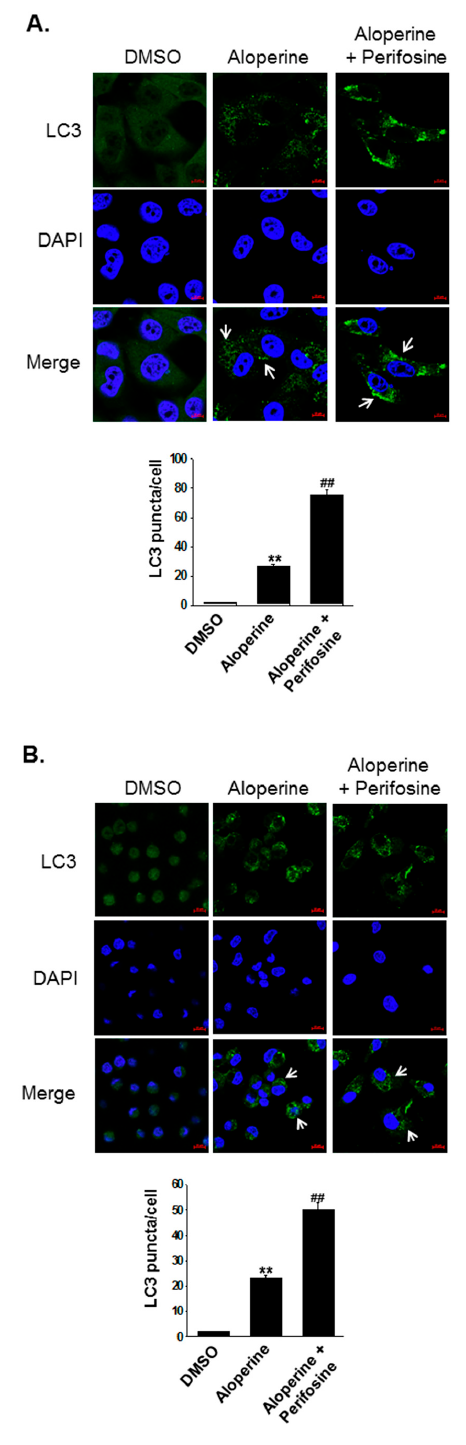
Figure 7. Promotion of aloperine-mediated autophagosome formation via the suppression of Akt pathway activation in human thyroid cancer cells. ( A ) KMH-2 and ( B ) IHH-4 cells were treated with aloperine (200 µ M) alone or in combination with perifosine (20 µ M) for 24 h, and autophagosome formation was examined with immunofluorescence staining ( green ). DAPI was used to label the nucleus ( blue ). DMSO was used as a negative control. Cells with elevated autophagosome signaling are labeled with an arrow. Autophagosome puncta in cells were identified and quantified in 30 cells. ** p < 0.01, compared with the DMSO group. ## p < 0.01, compared with the aloperine group. Three independent experiments were performed, and results of one of these are